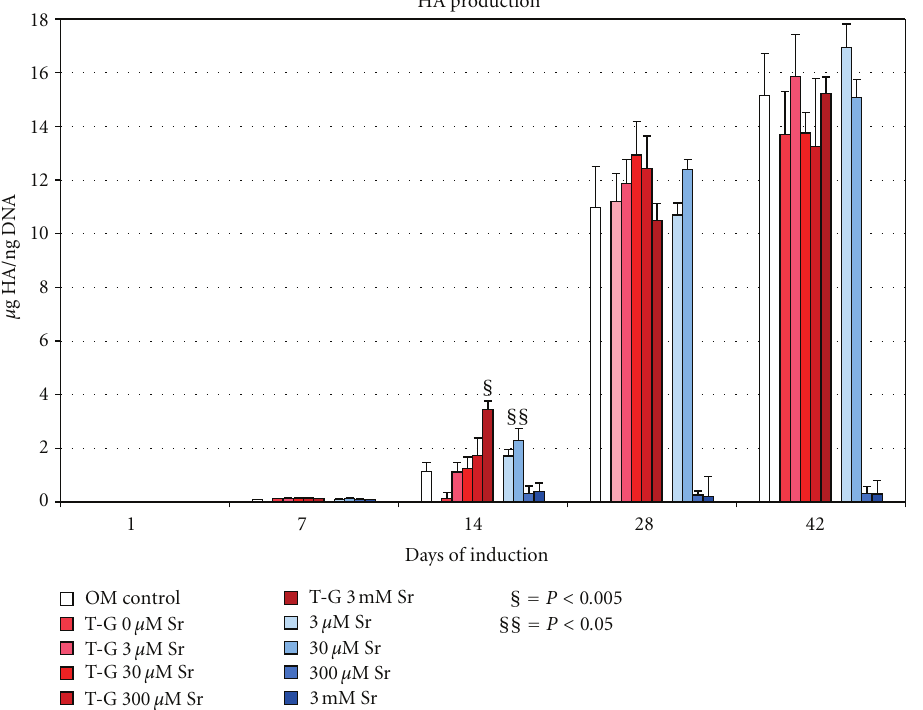
Figure 3: Quantitative analysis of the formation of HA deposits in PA2-E12 cultured on tPS from 1 to 42 days in OM in presence of transwell containing CMCA hydrogel (T-G) enriched with scalar concentrations of strontium (T-G 0, 3, 30, 300 μ M and 3mM Sr 2+ ) or in OM only containing scalar concentrations of strontium (3, 30, 300 μ M and 3mM Sr 2+ ). The control is represented by cells cultured in OM without Sr 2+